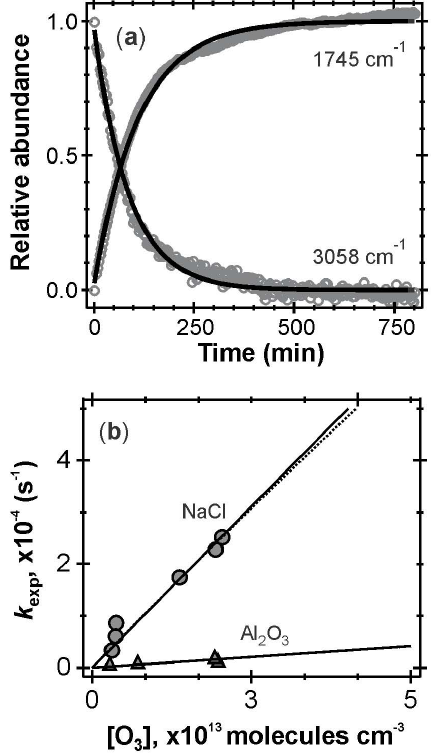
Fig. 5. (a) Kinetics integration of 3058cm − 1 peak (4- propylguaiacol aromatic CH stretch) and 1745cm − 1 peak (product carbonyl vibration). Exponential fits find k exp = 1 . 95 × 10 − 4 s − 1 and 1 . 50 × 10 − 4 s − 1 for 3058 and 1745cm − 1 peaks, respectively. (b) Plot of k exp vs. ozone concentration for 4-propylguaiacol adsorbed on NaCl (circles) and α -Al 2 O 3 (triangles). Solid line fits correspond to Eley–Rideal-type mechanism; dashed line fits correspond to Langmuir–Hinshelwood